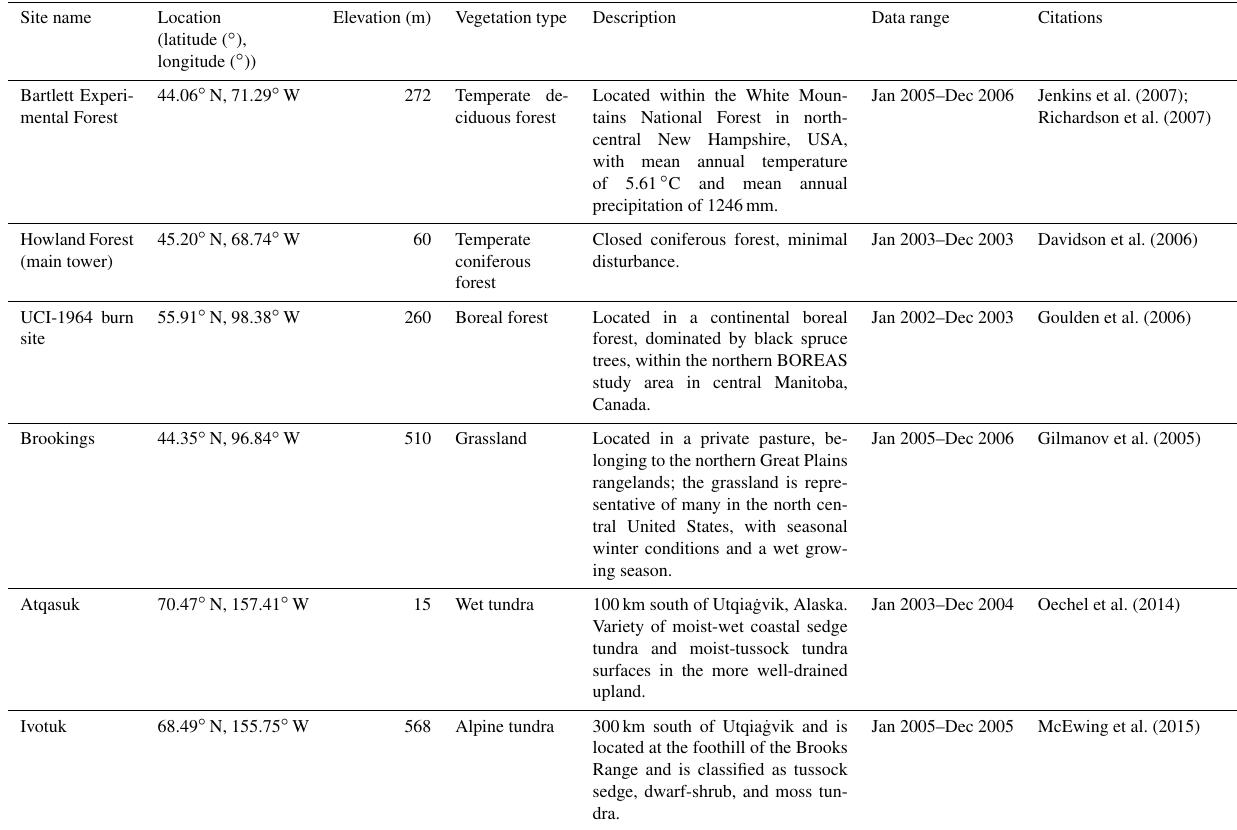
Table 3. Site description and measured NEP data used to validate TEM_Moss.